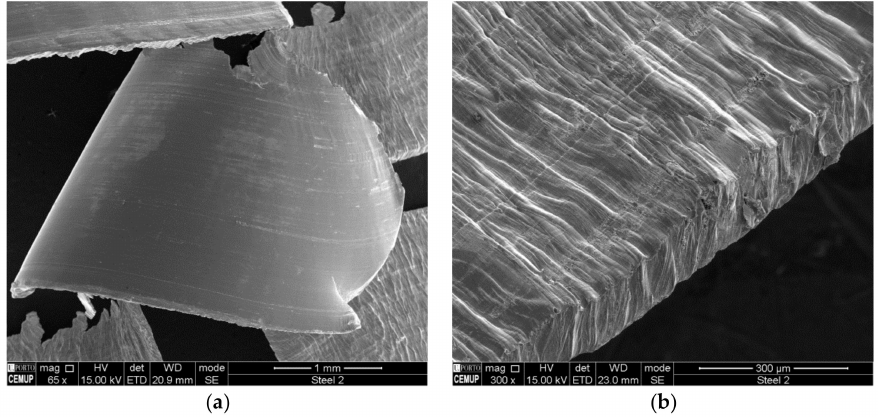
Figure 14. Chip obtained during the milling trials (( a ) and b